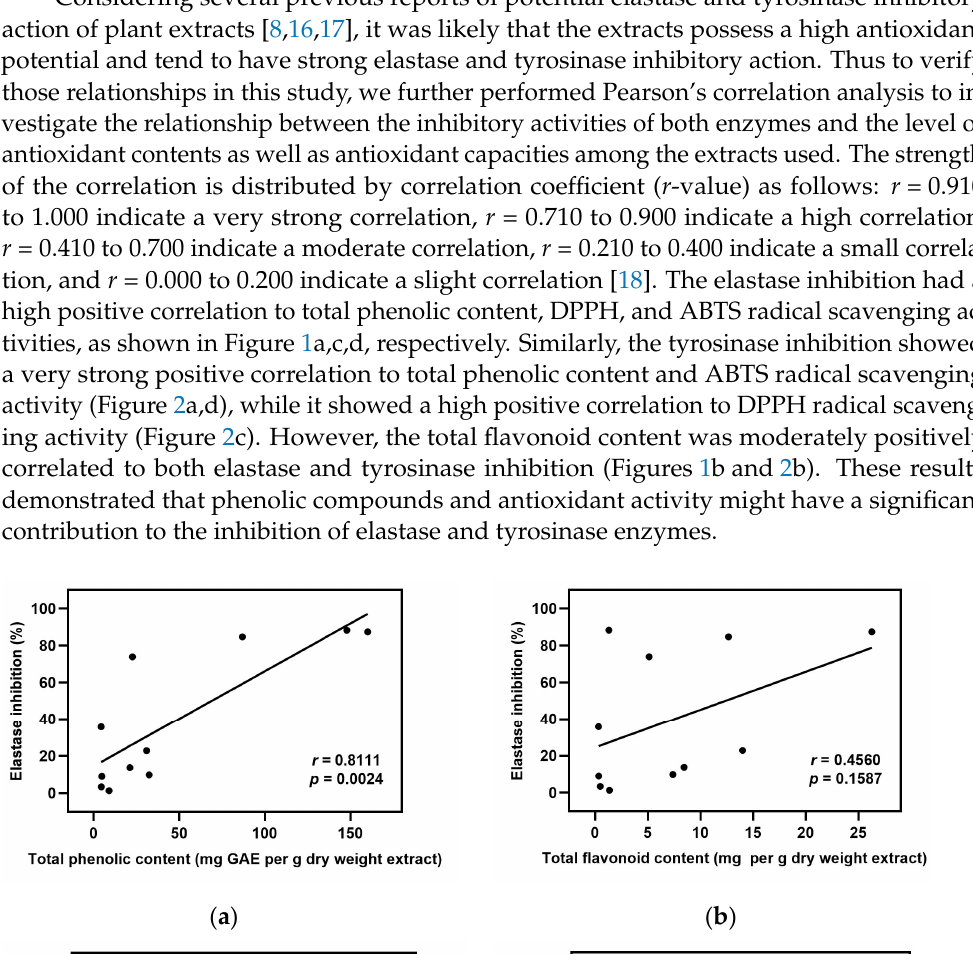
( d ) Figure 2. Correlation analysis between tyrosinase inhibition and values in Tables 1 through 4 were expressed as Pearson’s correlation coefficients ( r ): ( a ) tyrosinase inhibition versus total phenolic con- tent; ( b ) tyrosinase inhibition versus total flavonoid content; ( c ) tyrosinase inhibition versus DPPH free radical scavenging activity; ( d ) tyrosinase inhibition versus ABTS free radical scavenging activ- ity. 2.9. Molecular Docking We next evaluated the abilities of phytochemical compounds in the three most effec- tive plants with strong inhibition against elastase or tyrosinase enzymes. Molecular dock- ing is generally used to predict the binding affinity of compounds to protein receptors or enzymes compared to known inhibitors. According to our results of in vitro screening assays, we found that A. occidentale was the most potent elastase inhibitor, followed by G.